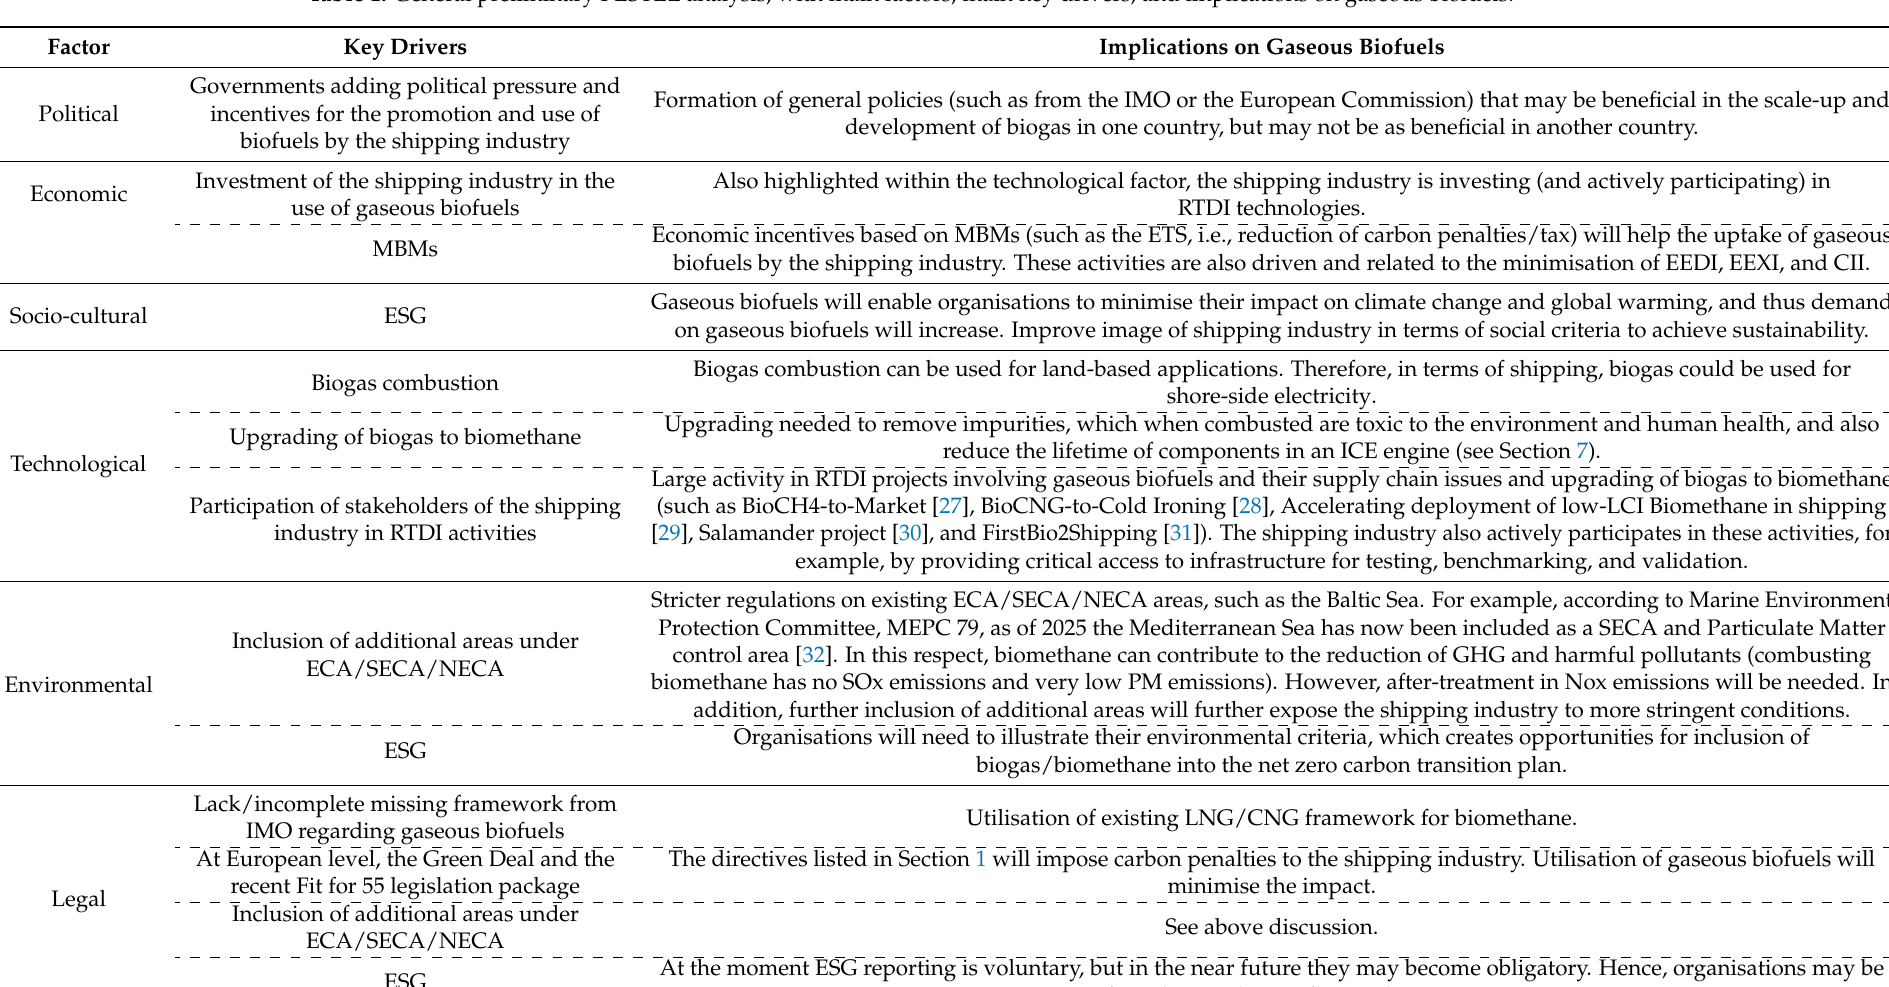
Table 1. General preliminary PESTEL analysis, with main factors, main key drivers, and implications on gaseous